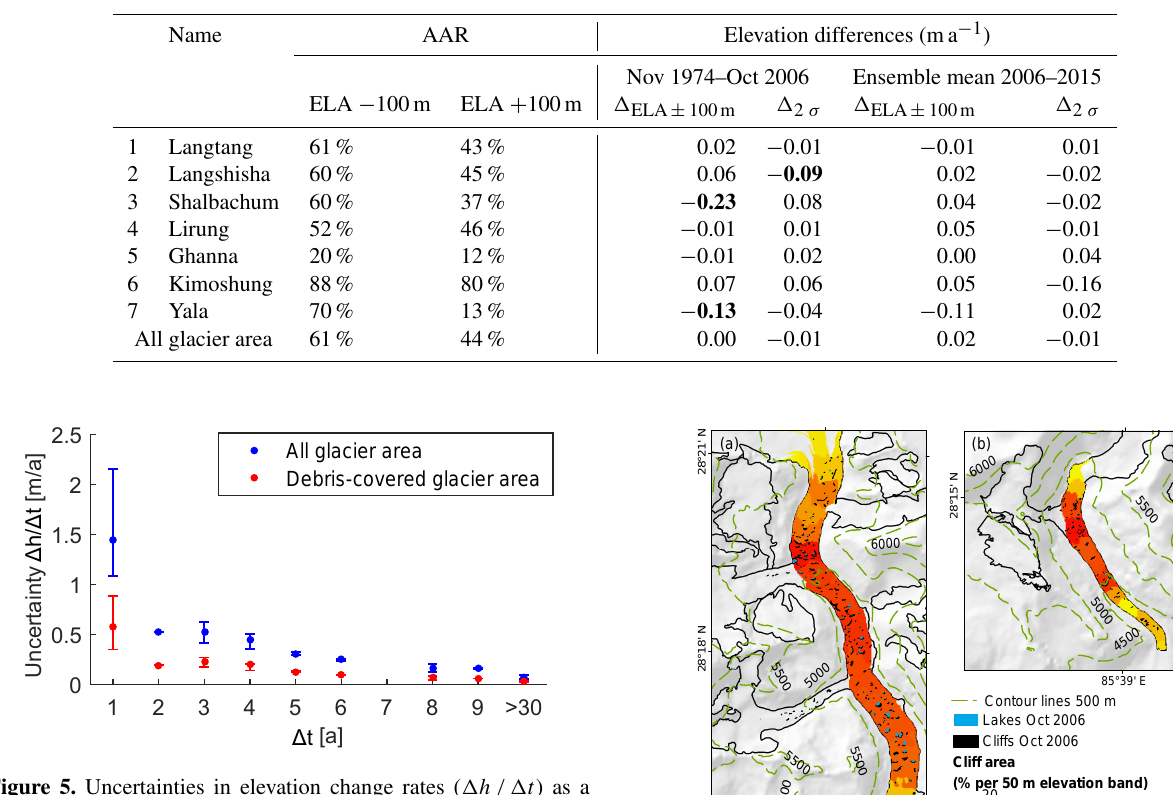
Table 5. Sensitivity to outlier correction and equilibrium line altitude (ELA) definitions. (cid:49) 2 σ is the difference in results if a 2 σ level is used to define outliers at all area types instead of a 3 σ level above and a 1 σ level below the ELA. The estimated ELA is 5400ma.s.l. (Sugiyama et al., 2013; Ragettli et al., 2015). (cid:49) ELA ± 100m represents the differences in results obtained with an ELA at 5500ma.s.l. in comparison to results obtained with an ELA at 5300ma.s.l. Sensitivity values that exceed uncertainty ranges as indicated in Table 4 are printed in bold letters.